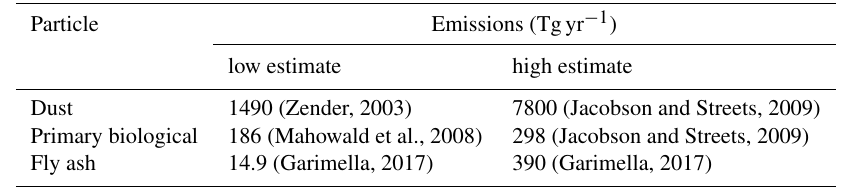
Table 4. Literature estimates of emission rates of primary biological particles, dust and fly ash.